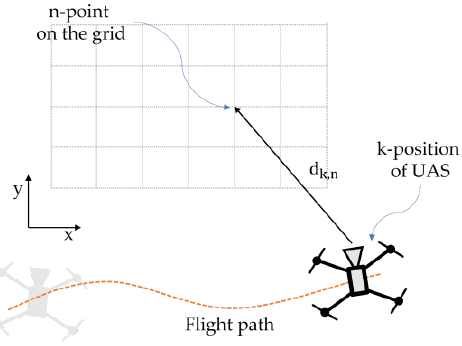
Figure 8. Focusing algorithm principle.